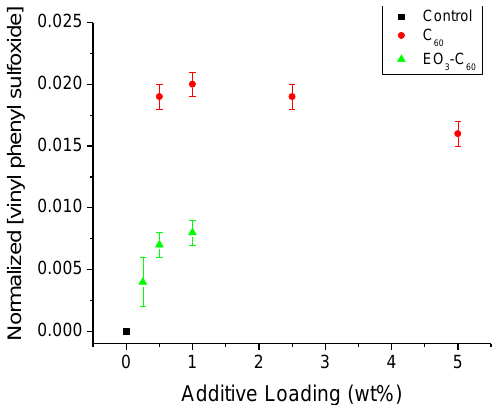
Figure 10. CEPS byproduct resulting from residence on Tecoflex films of several additive concentrations following exposure to daylight conditions for 18